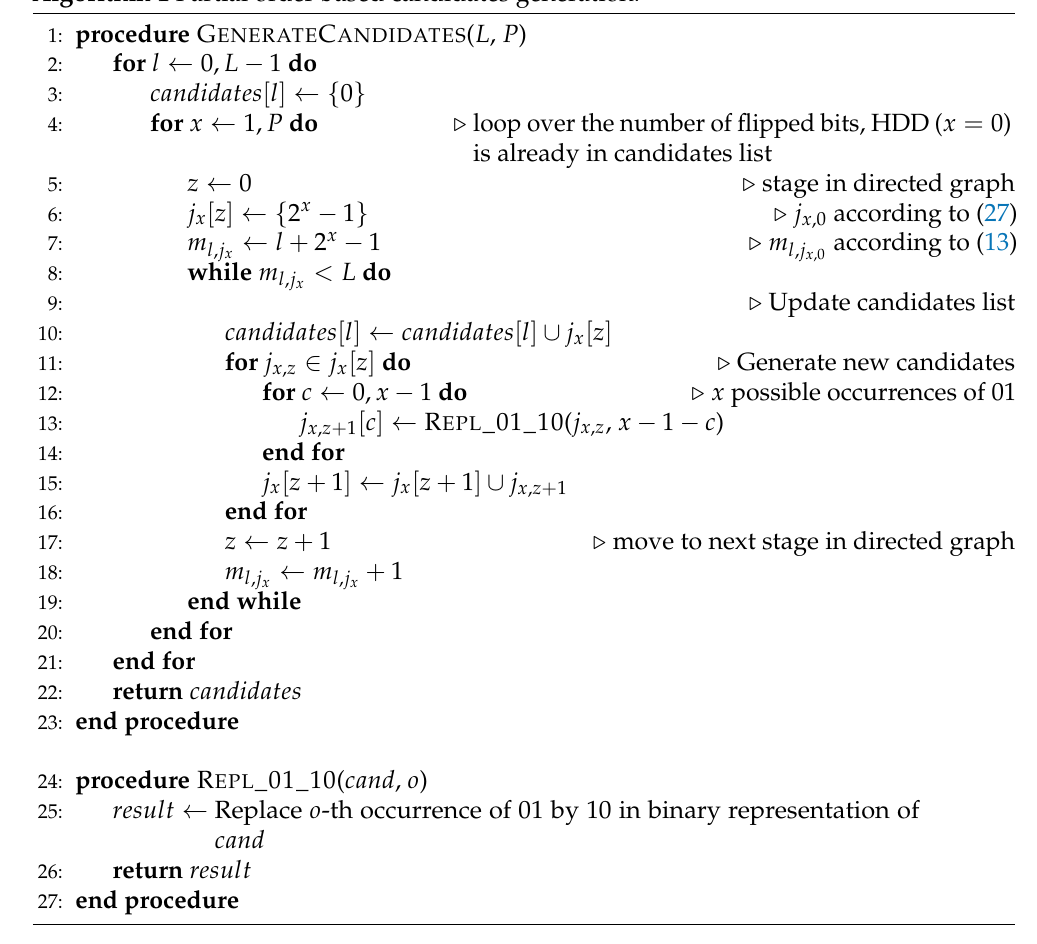
Algorithm 1 Partial order based candidates